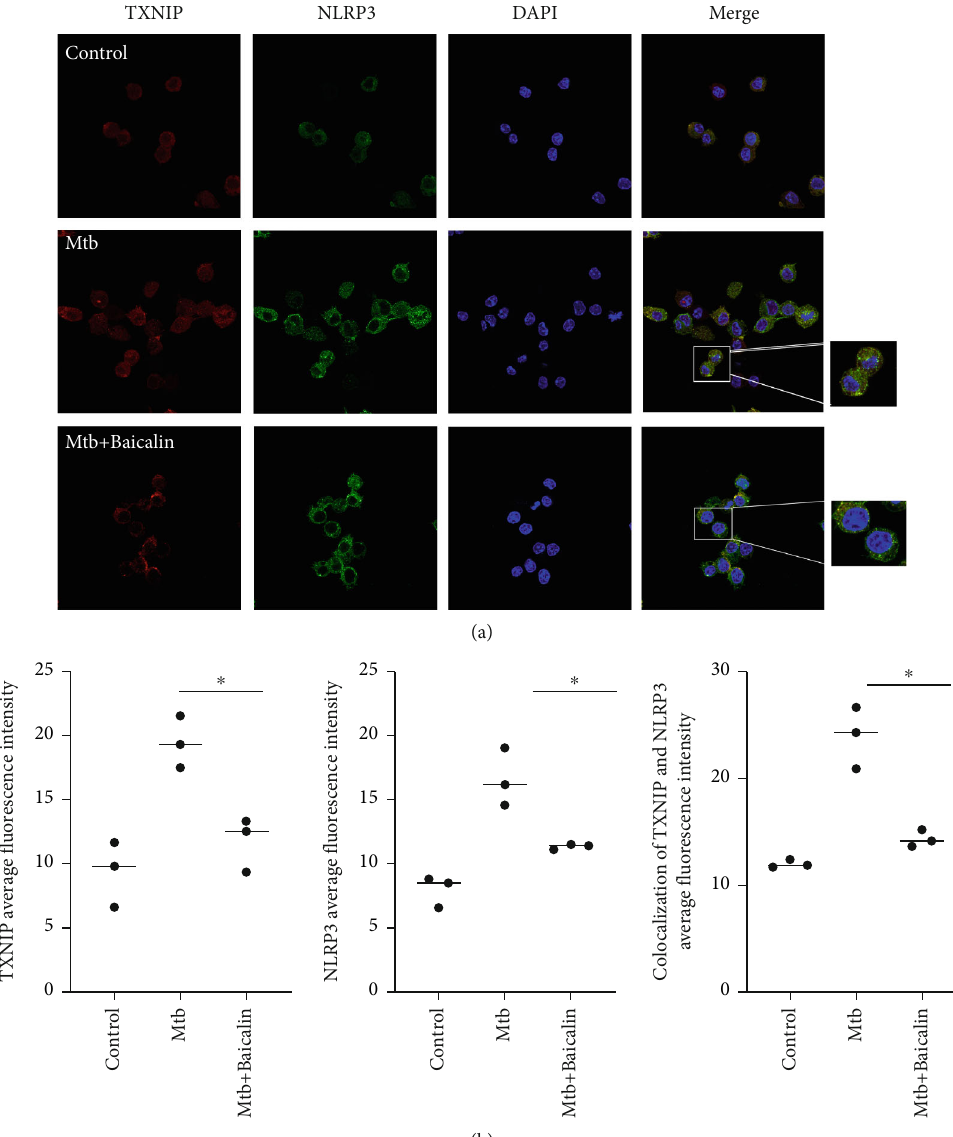
Figure 3: Baicalin prevents the colocalization of TXNIP and NLRP3 in Mtb-infected macrophages. (a, b) Confocal microscopy of RAW264.7 cells with di ff erent treatments immunostained with anti-TXNIP (red), anti-NLRP3 (green), and DAPI (blue). Mean ± SD of colocalization of TXNIP and NLRP3, TXNIP and NLRP3 fl orescence intensity in three independent pictures was shown as scatter plot and error bar ( n = 3 ). Kruskal-Wallis H rank and inspection was used as the statistical analysis method. According to the statistical results of Kruskal-Wallis H rank sum test, p < 0 : 05 . The di ff erence between the three groups was statistically signi fi